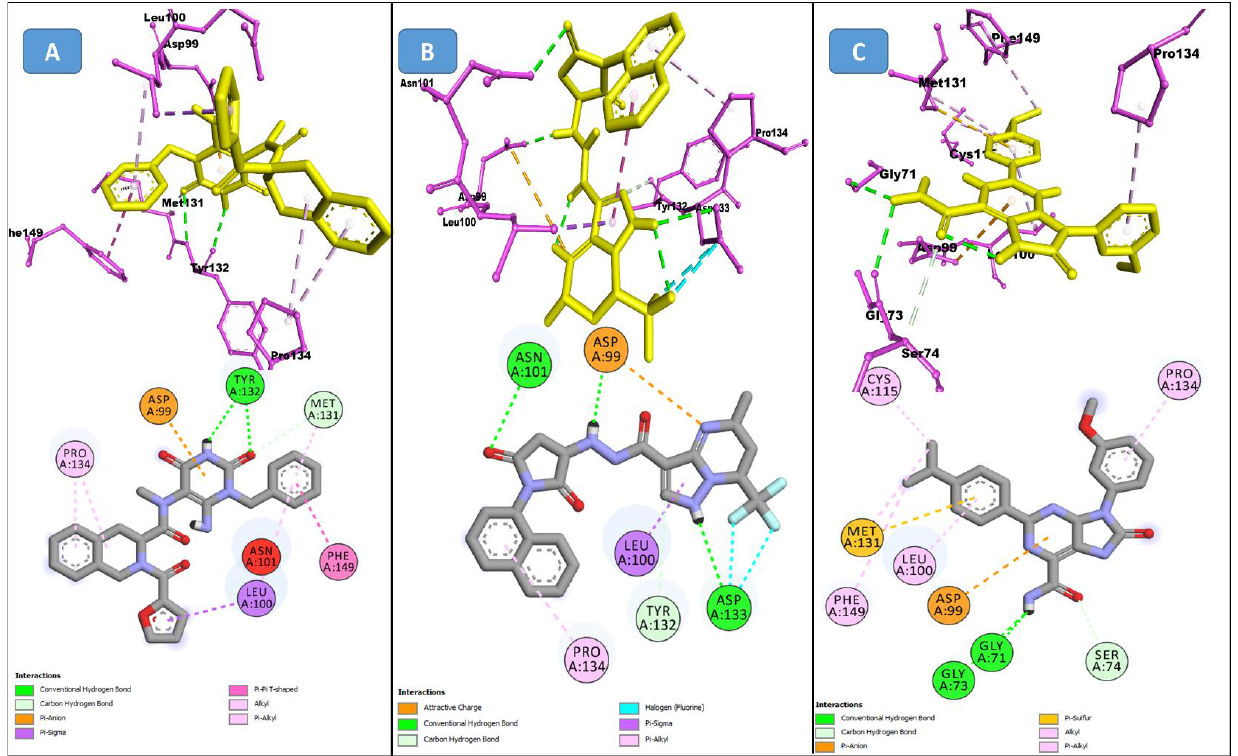
Figure 2. ( A ) represents the 3 (Upper panel) and 2-dimensional (Lower panel) interactive poses of ZINC000009464451, and ( B , C ) are the 3-dimensional representations of ZINC000002781694 and ZINC000004940454 with the SARS-CoV-2 MTase allosteric site respectively. ZINC000004940454 with the SARS-CoV-2 MTase allosteric site